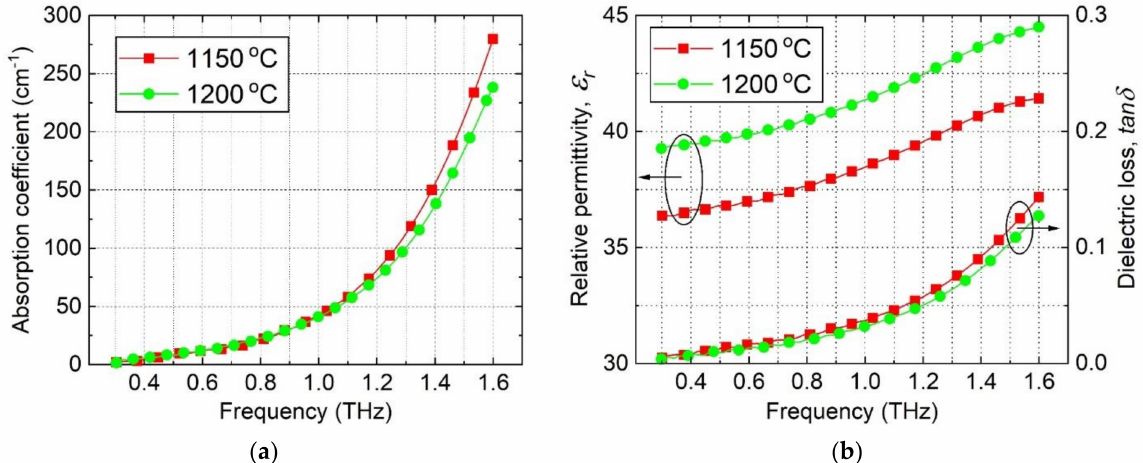
Figure 4. Frequency dependence of ( a ) the absorption coefficient, and ( b ) relative permittivity and the dielectric loss tangent versus sintering temperature for ZST ceramics (Samples A and B were sintered at 1150 ◦ C and 1200 ◦ C,